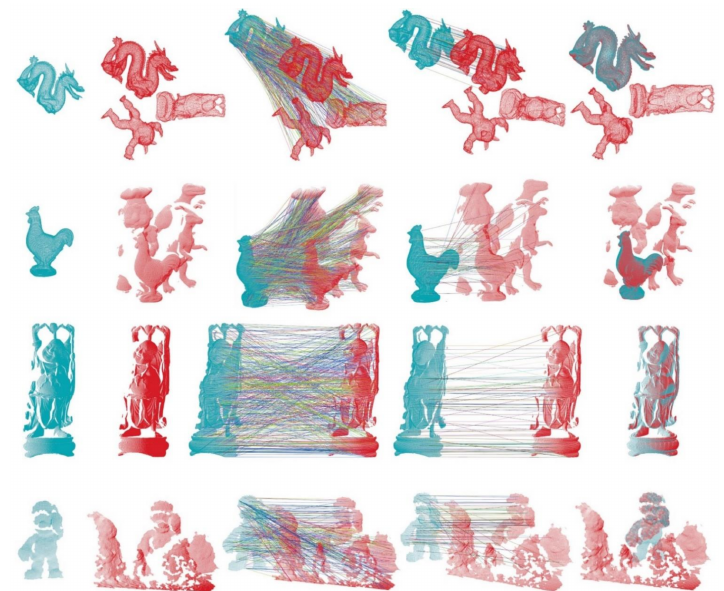
Figure 11. Sample visual registration results by our PPTFH descriptor on BR, UWA, SDSR, and Kinect datasets. From left to right: model point cloud (dark green color); scene point cloud (red color); correspondences by PPTFH+NNSR technology; correspondences by GC technology; and the registration result by RANSAC method.